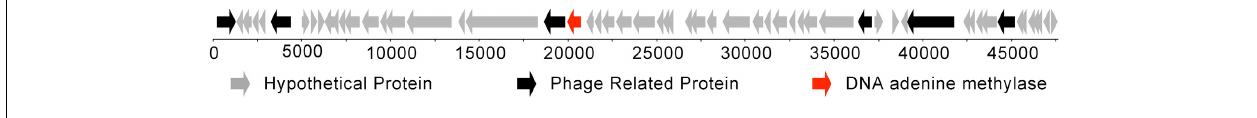
FIGURE 1 | Location of the DNA adenine methyltransferase (in red) within a bacteriophage present in the Bacteroides dorei genome.